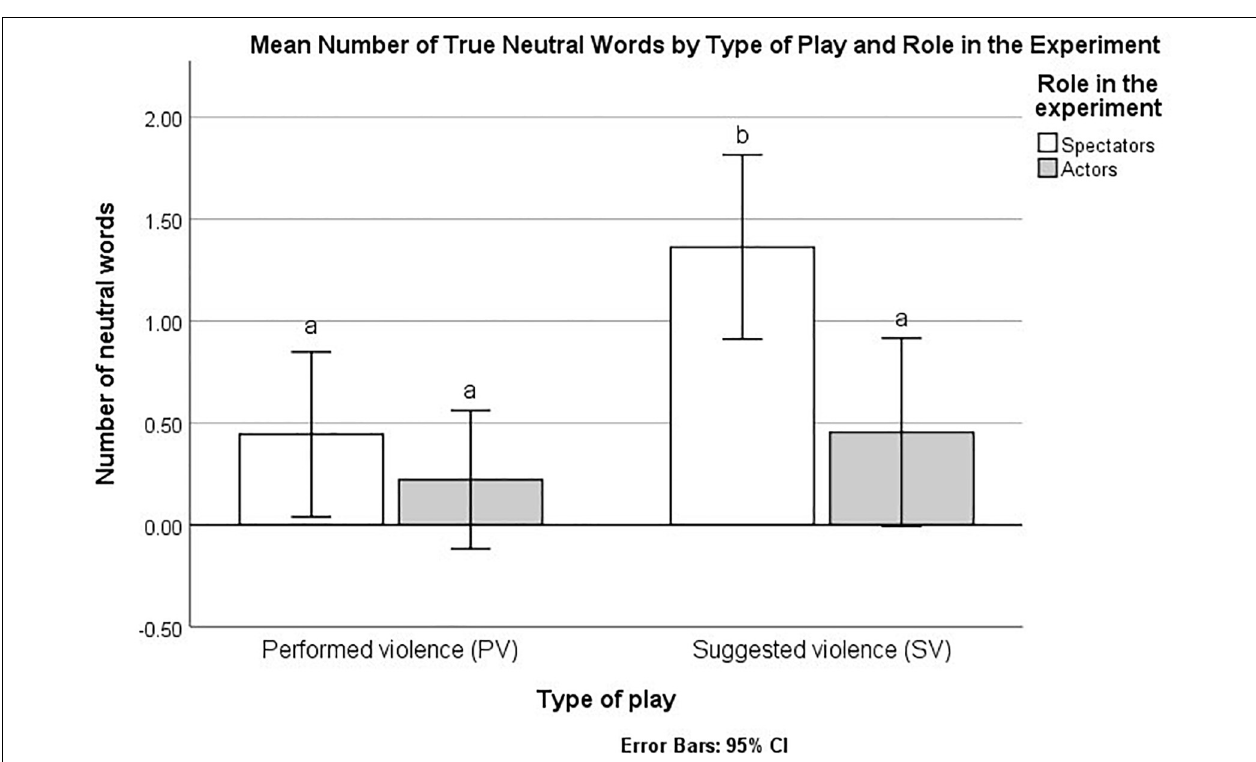
FIGURE 5 | Mean frequency of true neutral words recalled by type of play and role in the experiment. Bars marked by different letters indicate statistically significant differences based on a non-parametric analysis and B–H procedure for controlling false discovery rate (FDR).